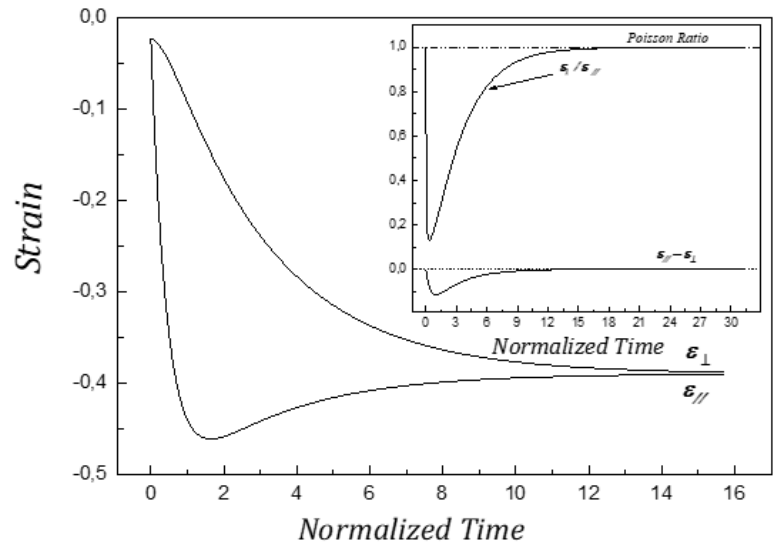
Figure 2. Theoretical simulations of the time evolution of anisotropic stain based on Equations 1, 3, and 4. The parameters used for the simulation are 𝐼 = 1 , 𝑃 2𝑡𝑐 = −0.05 , corresponding to cis orientation compared to trans orientation [36], and 𝑙 𝑐 𝑙 𝑡 ⁄ ≅ 0.61 , corresponding to 𝑙 𝑡 = 9 Å and 𝑙 𝑐 = 5.5 Å . The inset shows the transient of Poisson’s ratio (ϵ ⊥ ϵ ∥ ⁄ ) and (ϵ ∥ − ϵ ⊥ ) . Note that at saturation, the sample deforms equally in ϵ ∥ and ϵ ⊥ directions, i.e., ϵ ∥ = ϵ ⊥ .